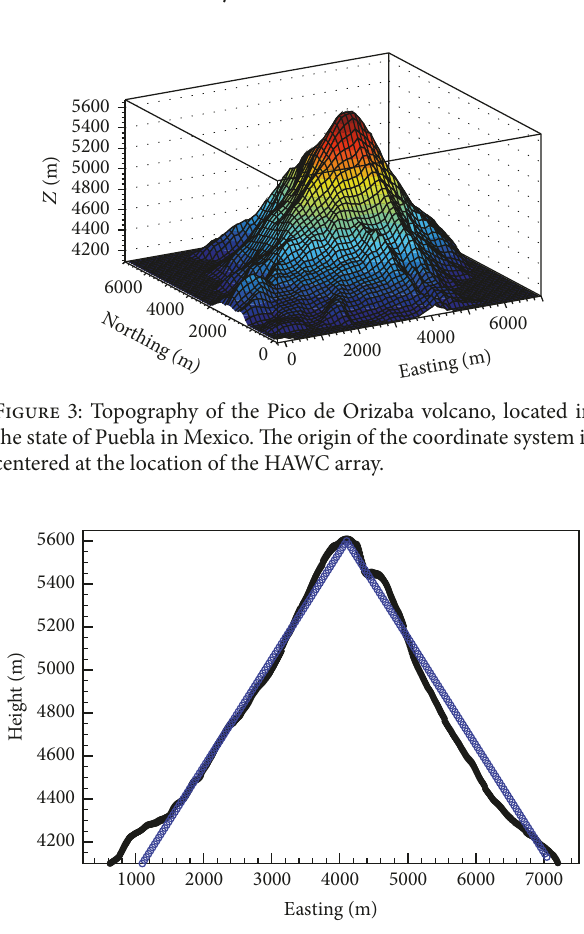
𝑧 -axis in the coordinate system shown in Figure